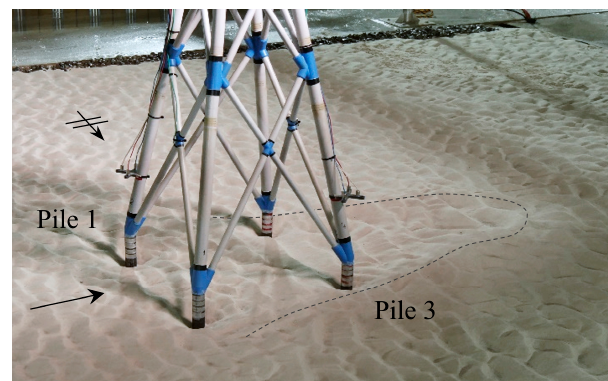
Figure 4. Exemplary photo of the model setup and scour pattern after test 4; the dashed line illustrates the extent of the global scour, current is coming from left to right with 0°, waves are propagating perpendicular in 90°.